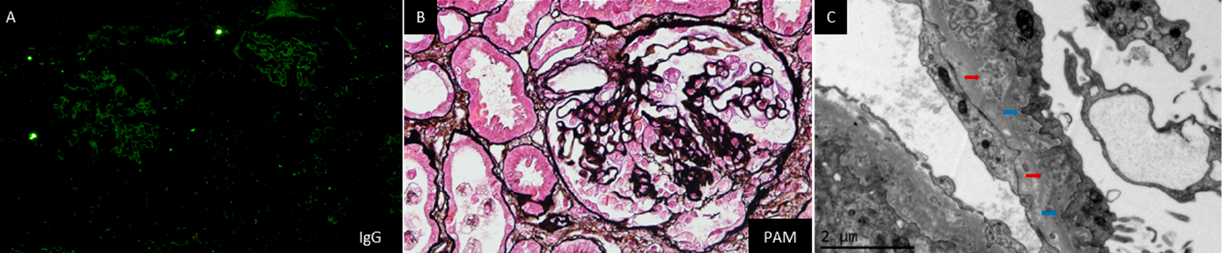
Figure 2. Representative pathological images of renal biopsy specimen form Case 2. Note: IF staining was positive for IgG ( A ) in capillary walls. Light microscopy showed segmental sclerosis with podocyte proliferation in 3/14 glomeruli and diffuse thickening of GBM (( B ), PASM + Masson, 400×). Electron microscopy showed diffuse podocyte foot process effacement, multiple podocyte infolding (blue arrow), and prominent microspheres forming clusters (red arrow) within the GBM (( C ), 20,000×).